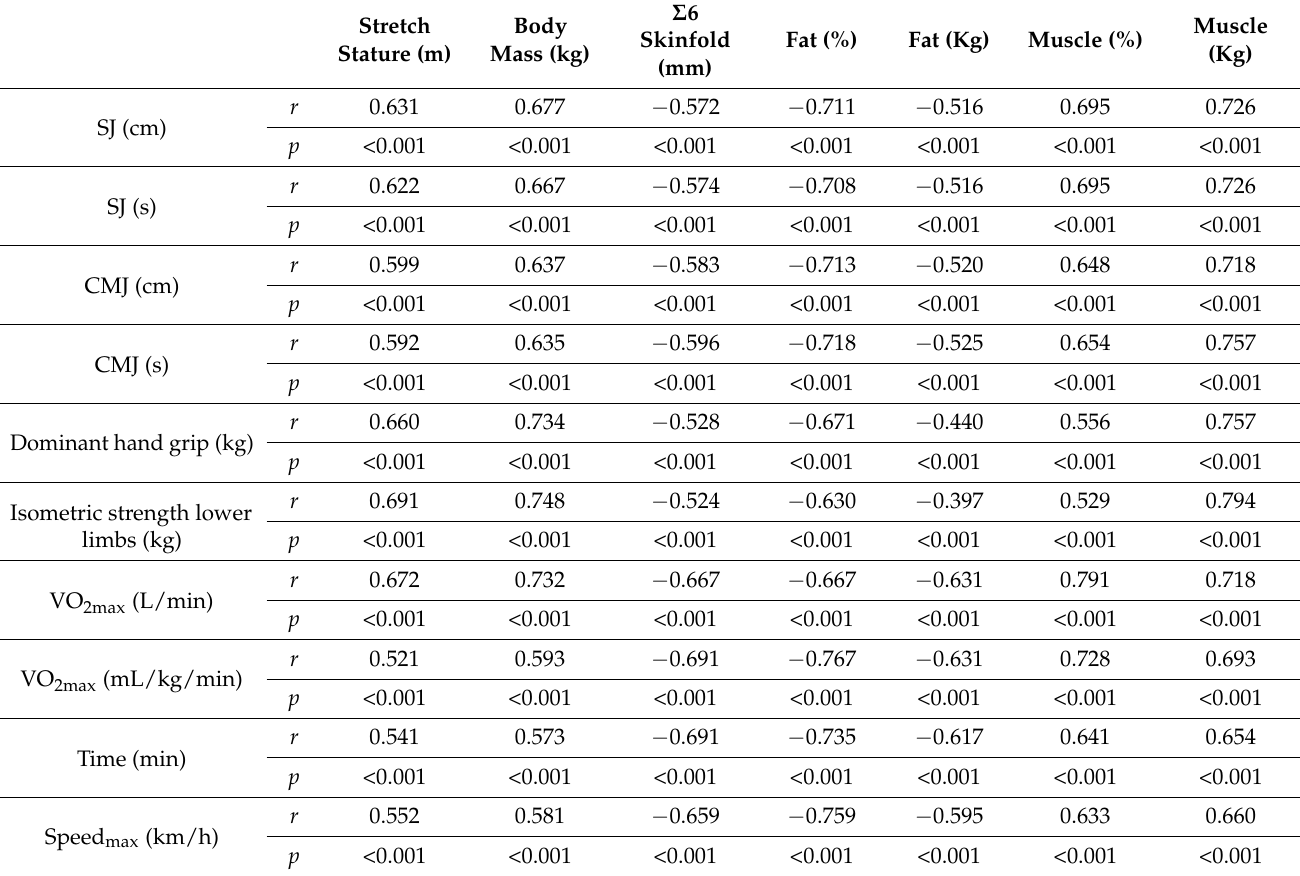
Table 4. Relationships between body composition and physical fitness parameters in all